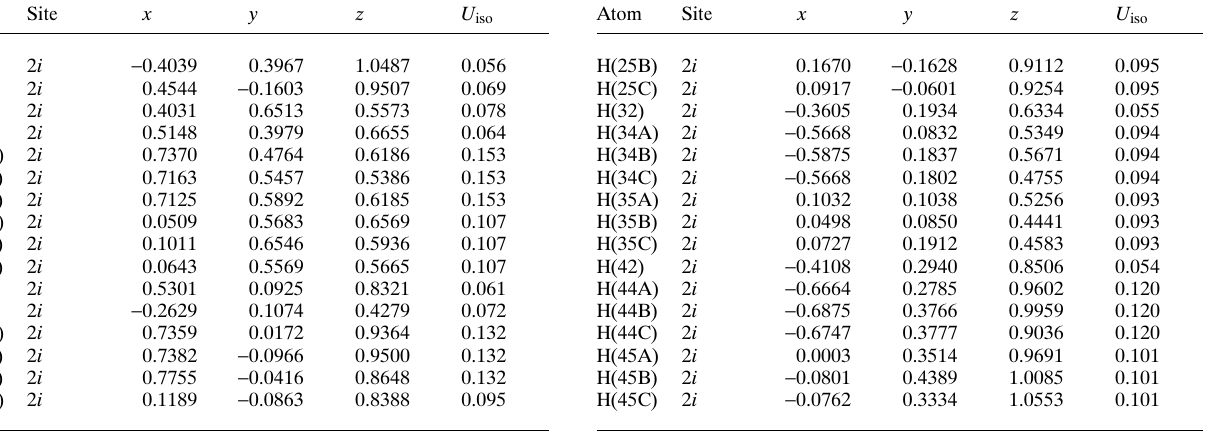
Table 3. Atomic coordinates and displacement parameters (in Å 2 ) . Atom Site Occ.